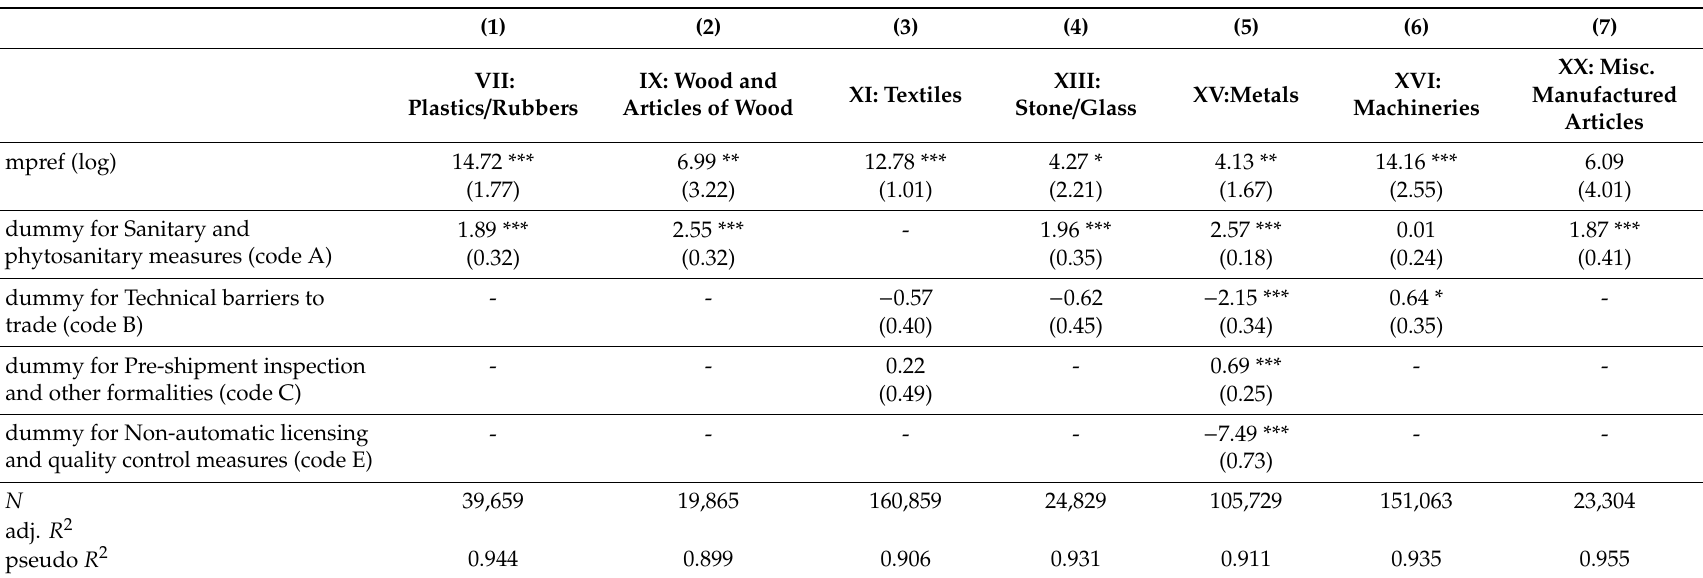
Table 5. Industry-wise analysis—impact on the intensive margin of